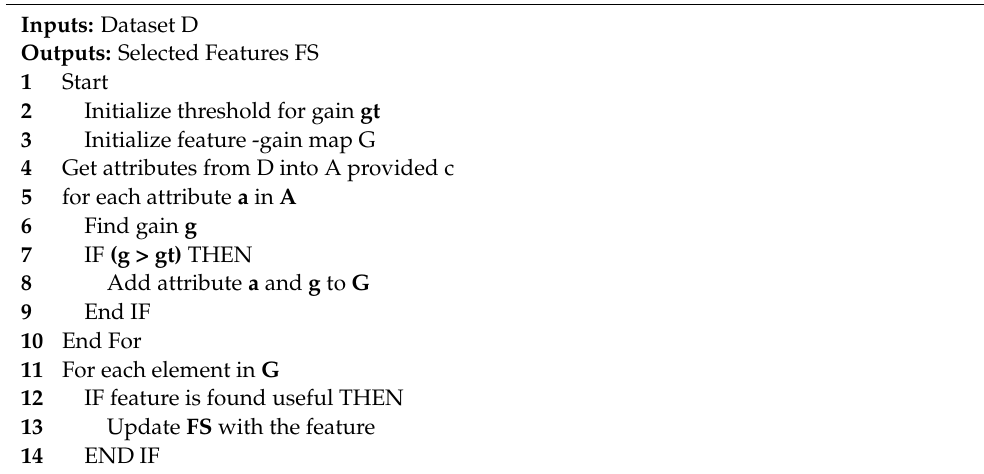
Algorithm 2 Information gain-based feature